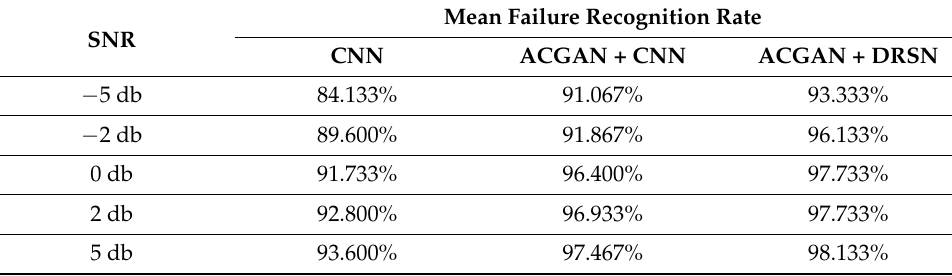
Figure 7. Fault classification ability under the circumstance of different noise . Table 2. Fault classification accuracy in the condition of different noises .